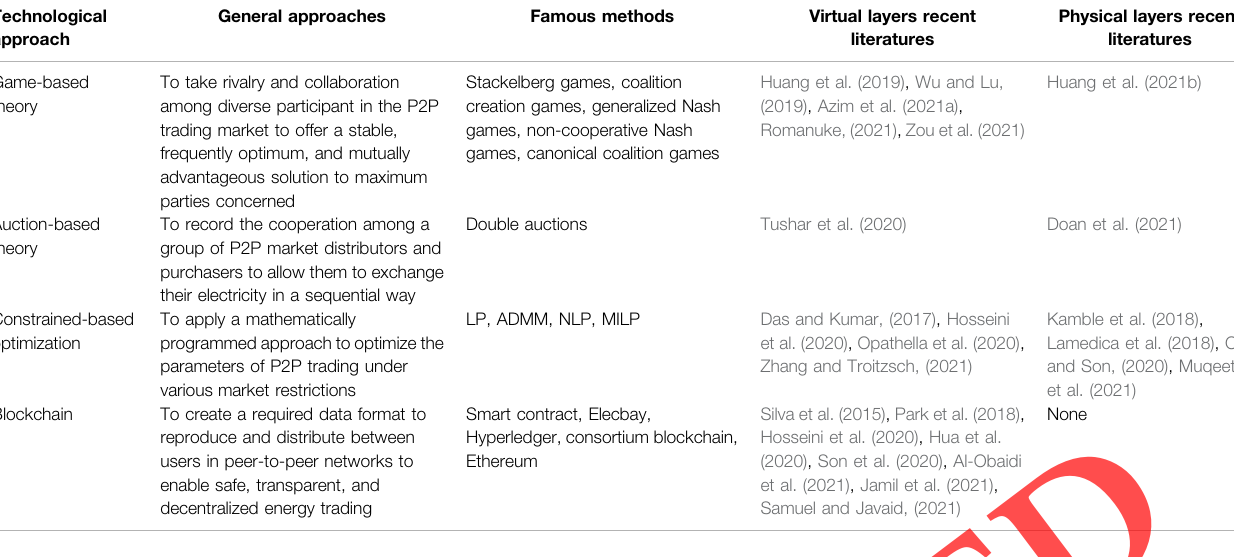
TABLE 2 | Summary of various technological approaches used for enabling the P2P